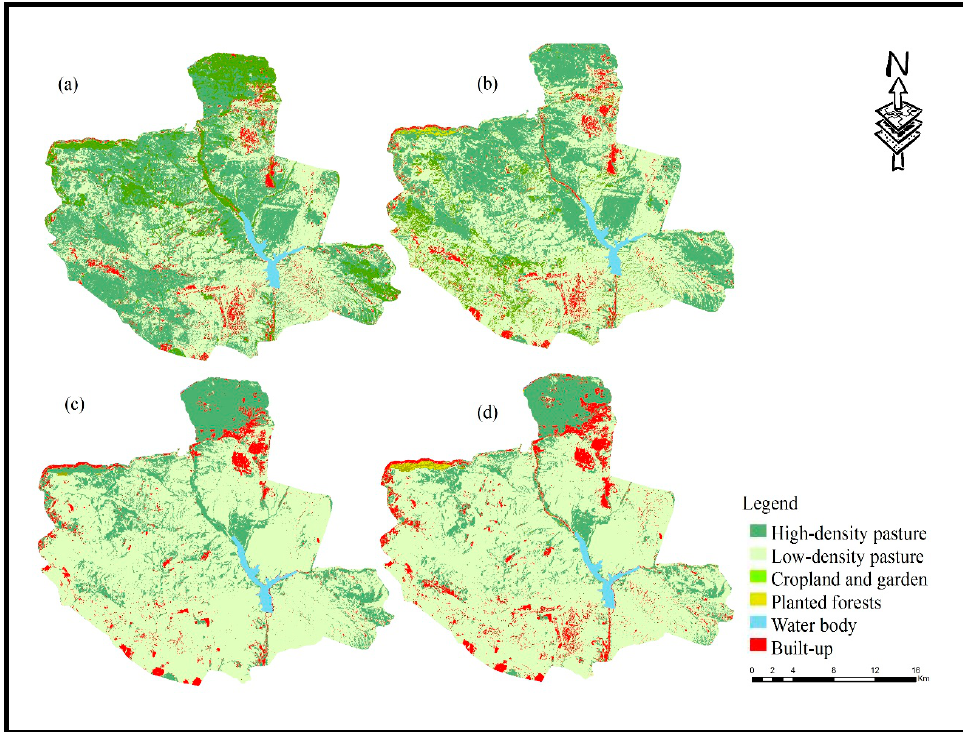
Figure 3. LULC changes for the Jajrud Protected Area, Iran: ( a ) 1989, ( b ) 1999, ( c ) 2009, ( d ) 2019.